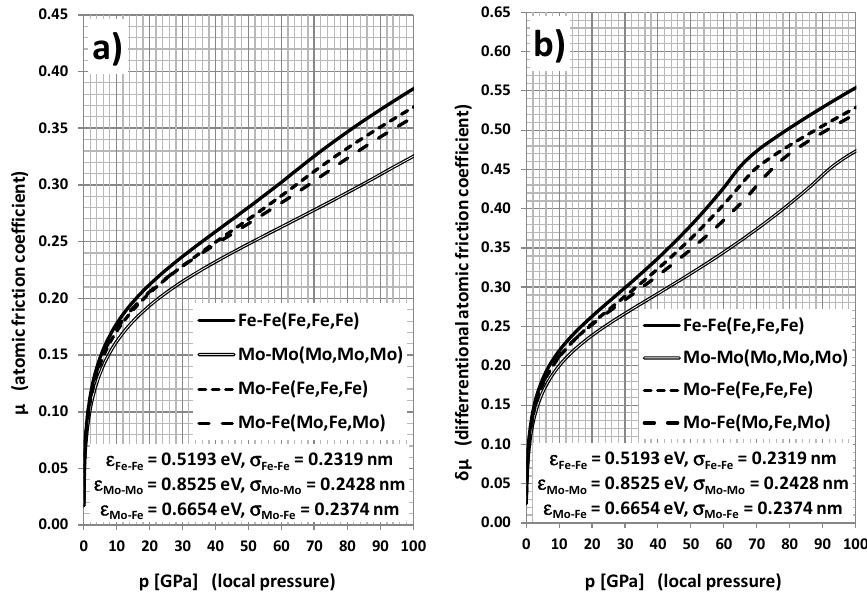
Figure 6. Regular ( a ) and differential ( b ) atomic friction coefficient dependence on local pressure for different atomic pairs: Fe-Fe(Fe,Fe,Fe), Mo-Mo(Mo,Mo,Mo), Mo-Fe(Fe,Fe,Fe), and Mo-Fe(Mo,Fe,Mo). Atoms specified in parentheses constitute a rigid environment of the “elastic” atom of base.